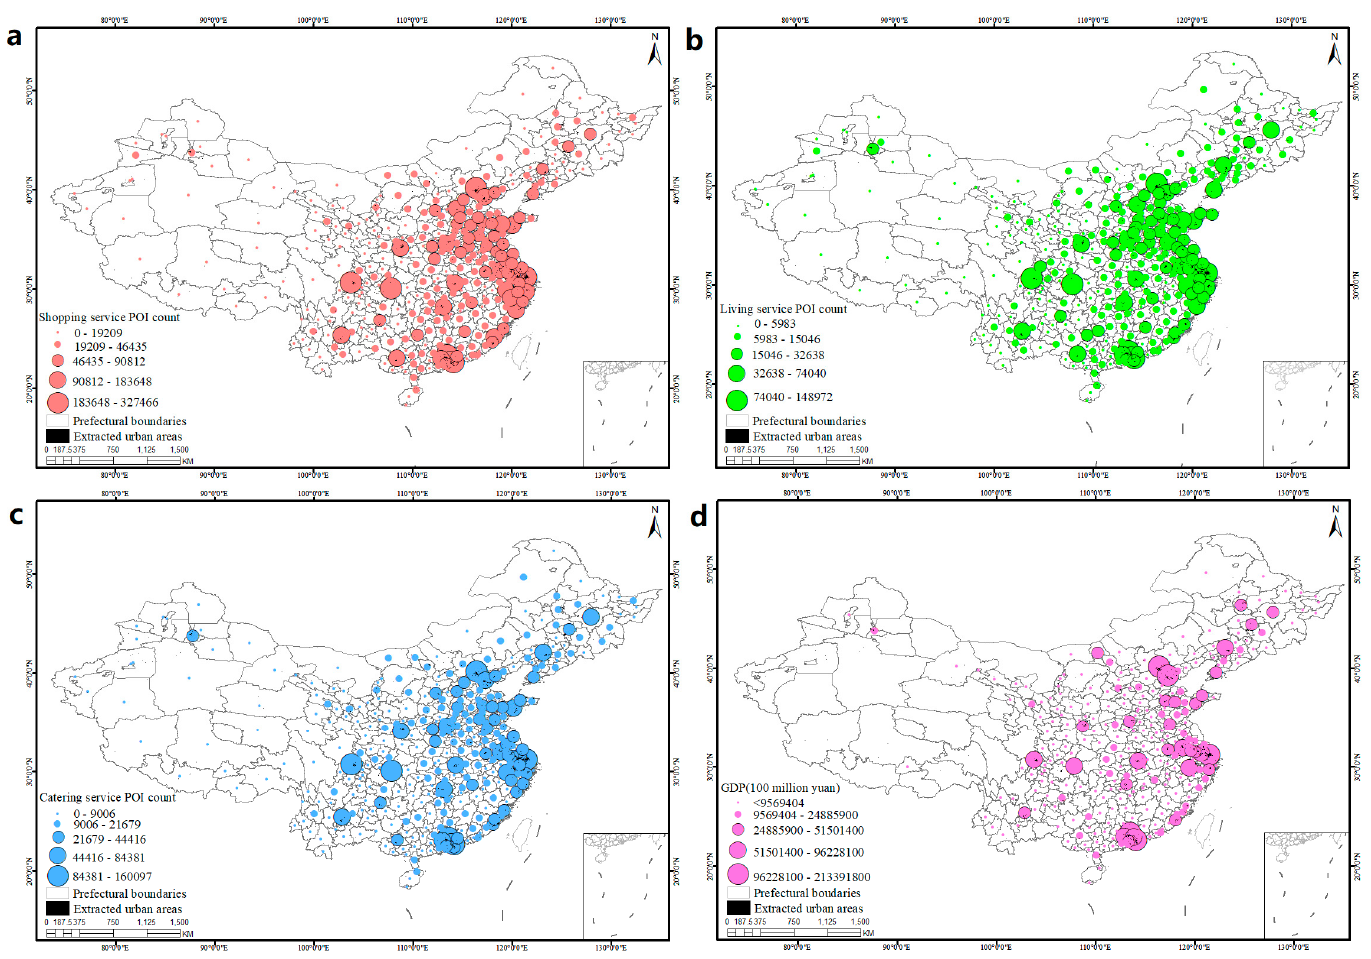
Figure 8. The statistical POI count and extracted urban areas in 2013 in NPP-VIIRS. ( a ) The statistical shopping service POI count and extracted urban areas; ( b ) The statistical living service POI count and extracted urban areas; ( c ) The statistical catering service POI count and extracted urban areas; ( d ) The GDP and extracted urban areas.